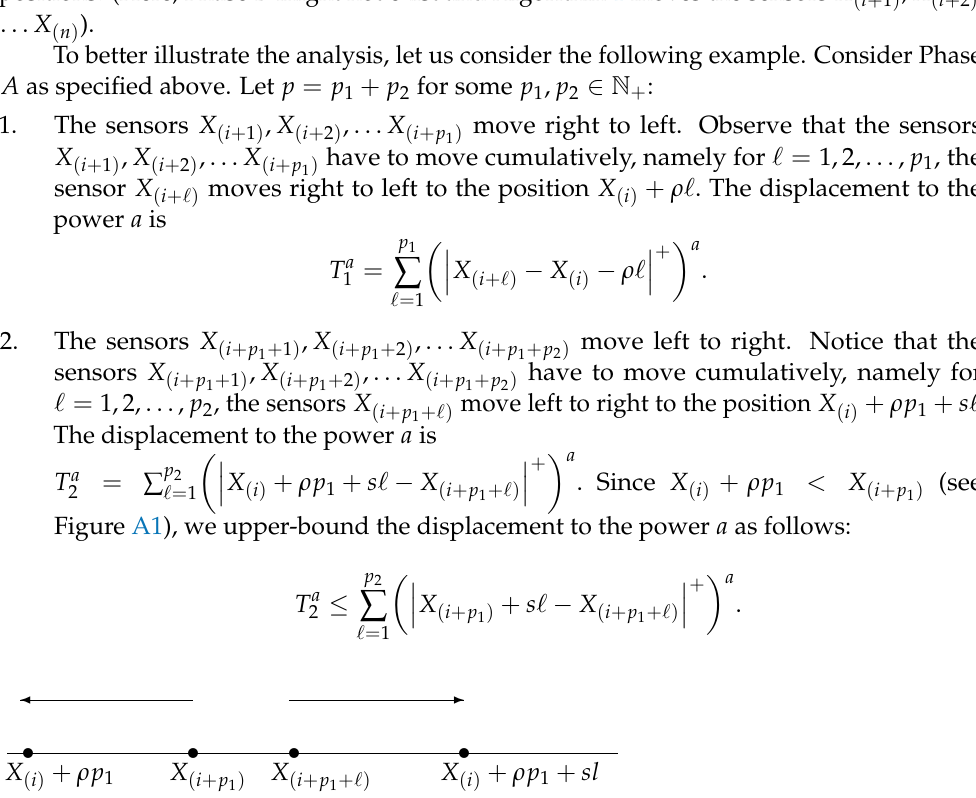
, X ( i + p specified by 1. and 2. in Phase A of 1 ) 1 + (cid:96) )